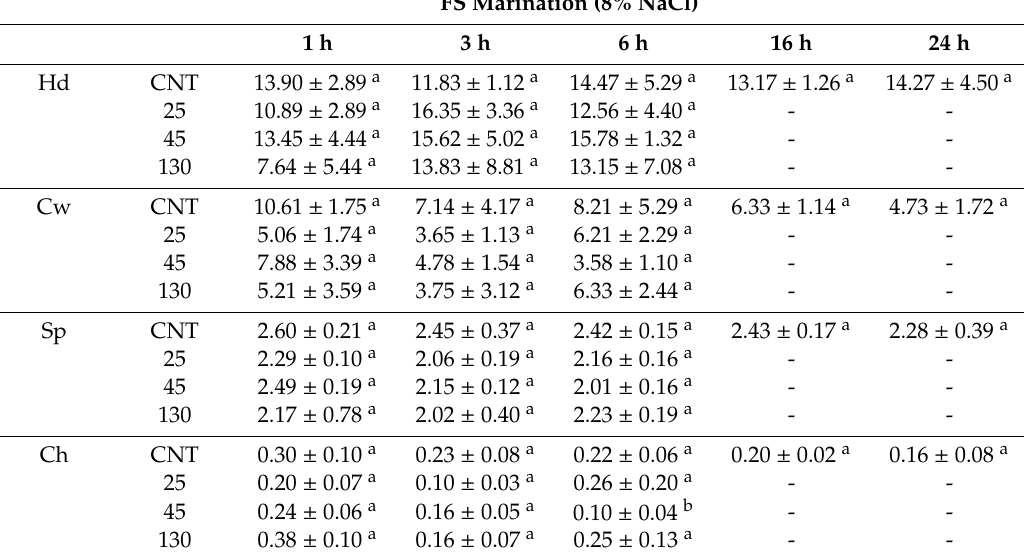
Table 3. Texture Profile Analysis (TPA) 1 parameters; Chicken breast samples were marinated using power ultrasound operating at a frequency of 25, 45 or 130 kHz for 1, 3 or 6 h. Values for chicken samples marinated without ultrasound (CNT) are also presented. Values represent means ± standard deviation (SD, N =